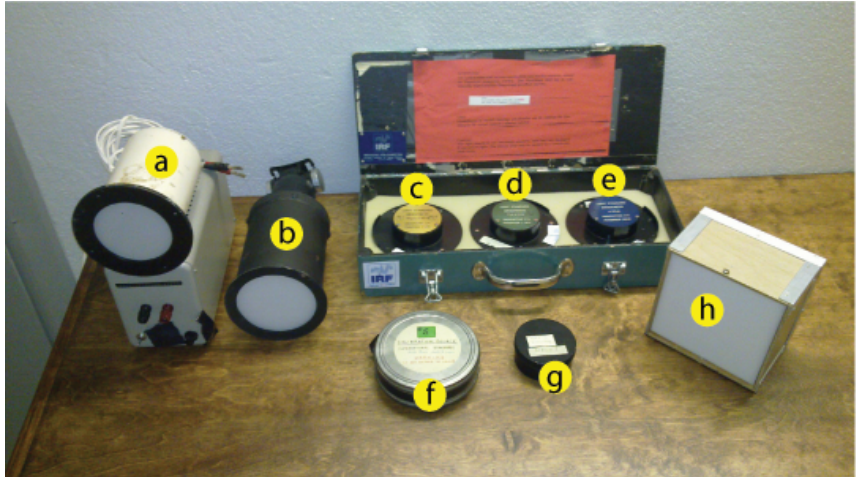
Fig. 2. Some of the low light sources intercalibrated at this workshop: (a) IRF Lauche lamp (SID 101) with power supply, (b) PGI Chernouss- 38AM (SID 105), (c) IRF UJO Y275 (SID 5), (d) IRF UJO L1614 (SID 4), (e) IRF UJO 920B (SID 3), (f) FP reference source (SID 1), (g) MPI-2 source (SID 2) and (h) IRF Lycksele lamp (SID